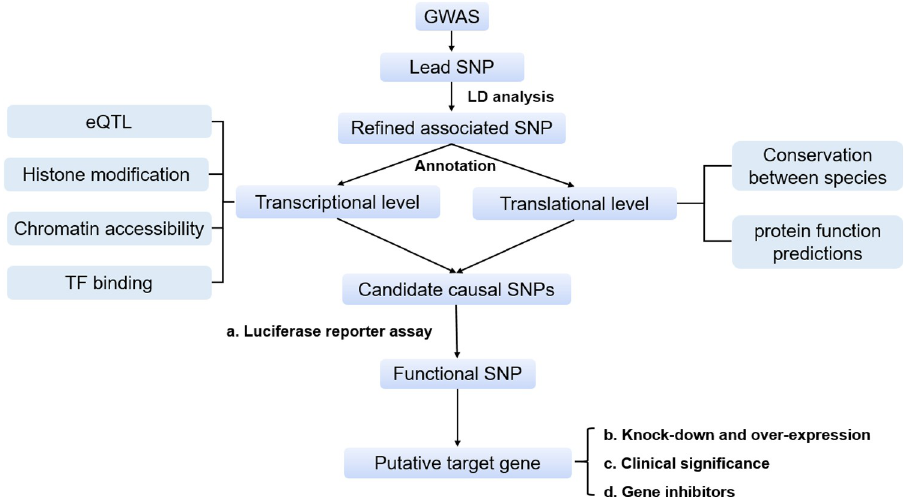
Fig 1. Flowchart of the comprehensive analysis strategy. CRC-related lead SNPs were obtained from the NHGRI-EBI GWAS catalog. LD calculation was performed to acquire SNPs in high LD with the lead SNPs (called refined associated SNPs) using the 1000 Genomes phase 3 dataset as the reference panel. Comprehensive functional annotation towards these SNPs was conducted at both the transcriptional and translational level to prioritize candidate causal SNPs. Then, various experimental methods were used to identify the functional SNPs and their putative target genes, such as reporter assays.